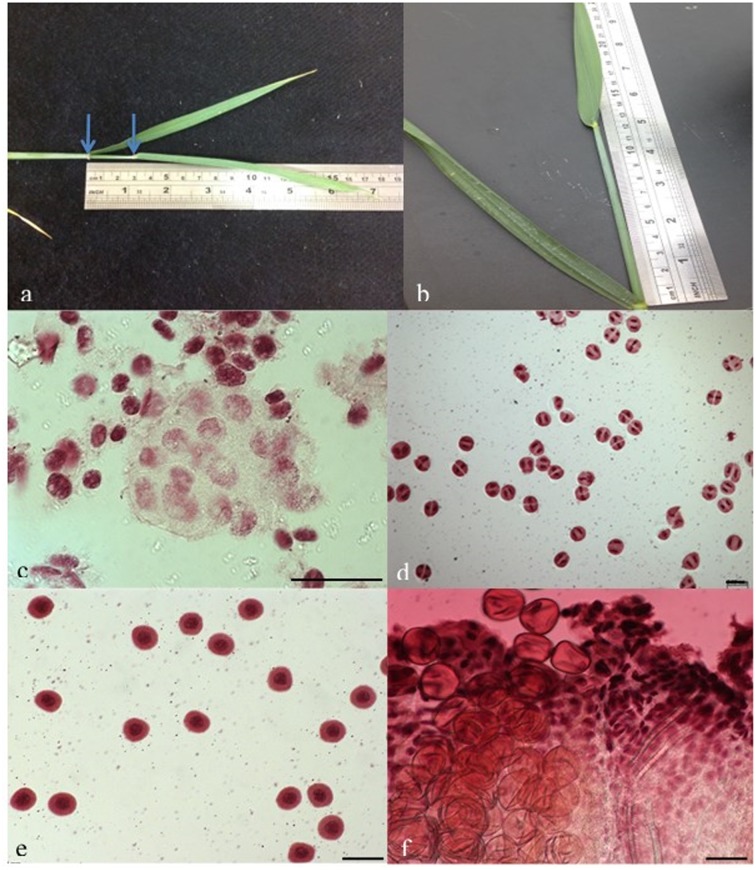
Correlation of auricle distance (AD) to meiosis stage in wheat. (a) AD = ∼3 cm when meiosis started for most genotypes; (b) AD = ∼12 cm when meiosis ended for most genotypes; (c) Microscopic examination of anthers at AD < 3 cm showing pollen mother cells (the lightly stained large cells in the middle) before meiosis; (d,e) Microscopic examinations of anthers at AD between 3 and 12 cm, showing cells (d) at different meiotic stages and (e) having just finished meiosis; (f) Microscopic examination of anthers at AD ≥ 12 cm, showing pollens that had already formed. Bars = 50 μm.